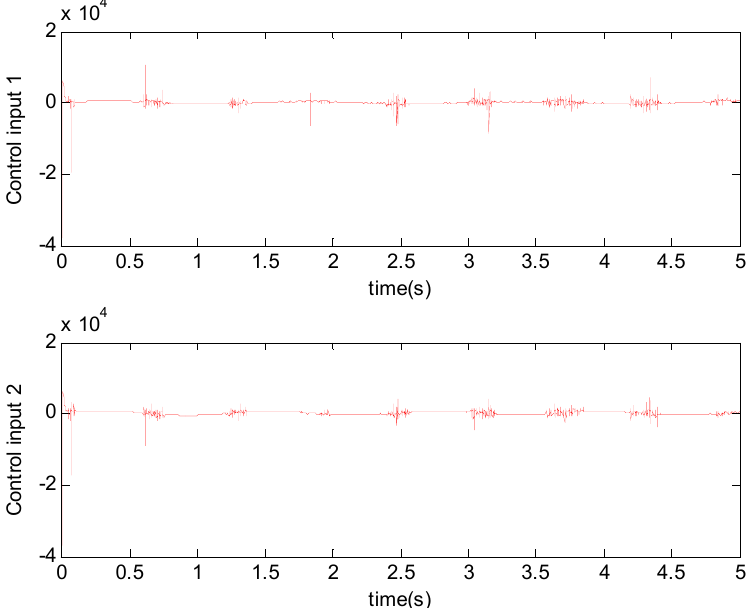
Figure 4. Tracking error using the ABFSMC approach.